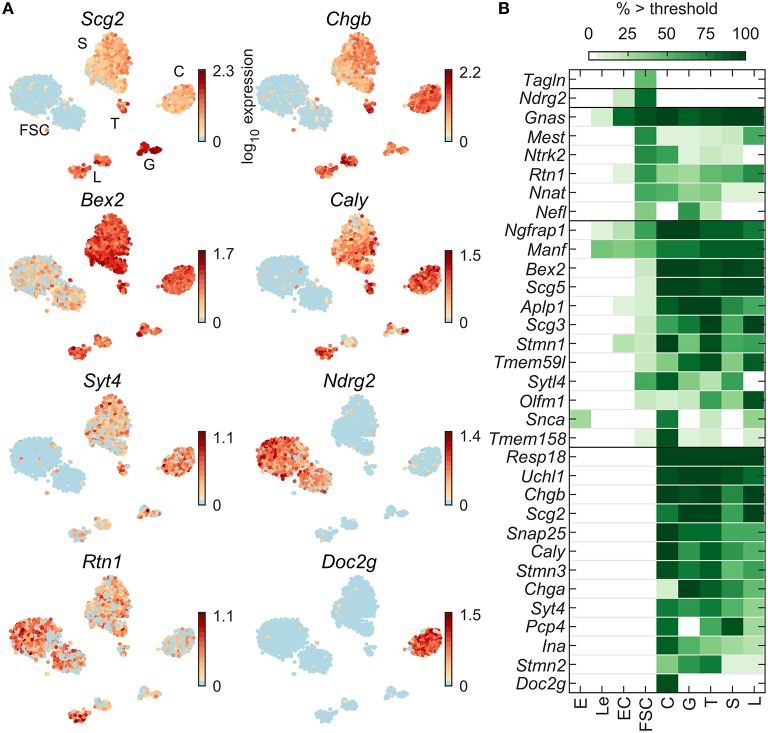
Expression of neuroendocrine marker genes. (A) tSNE map showing expression of select genes: granins (Scg2, Chgb), upstream modulators of receptor signaling (Bex2, Caly), downstream regulators of receptor signaling (Ndrg2), synaptotagmins (Syt4) and neuroendocrine cell vesicular trafficking (Rtn1, Doc2g). (B) Percentage of cells per type expressing select genes above threshold. From a manually selected list of neuroendocrine markers, 99 were expressed in at least 5% of cells in at least one cell type (Table 2) and 70 were pituitary dominant (Table S1). The 33 most highly expressed of these are shown.